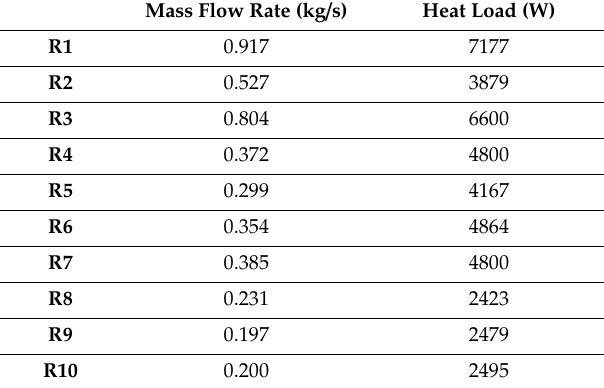
Table 3. Boundary conditions for the server racks—raised floor